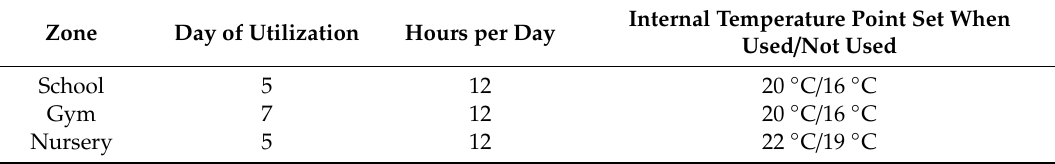
Table 5. Trend of building